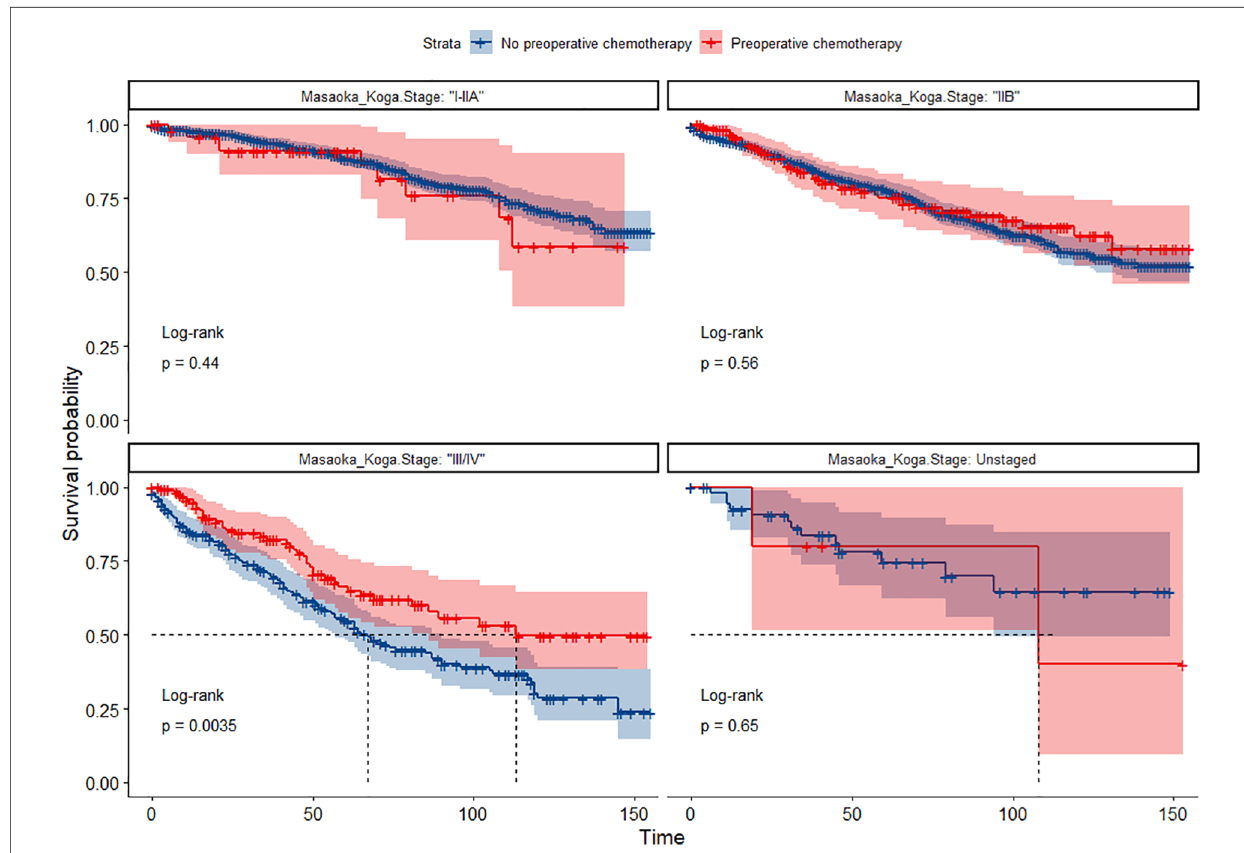
FIGURE 2 Survival curves of OS in the POCT group and no-POCT group in patients undergoing surgery for TETs at different stages before propensity